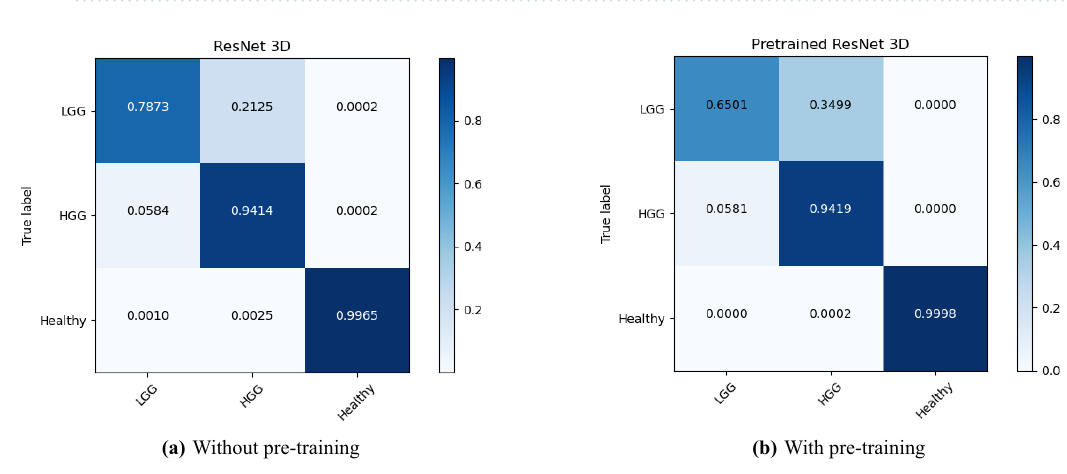
Figure 6. Confusion matrix for 3-fold cross-validation on ResNet3D18.